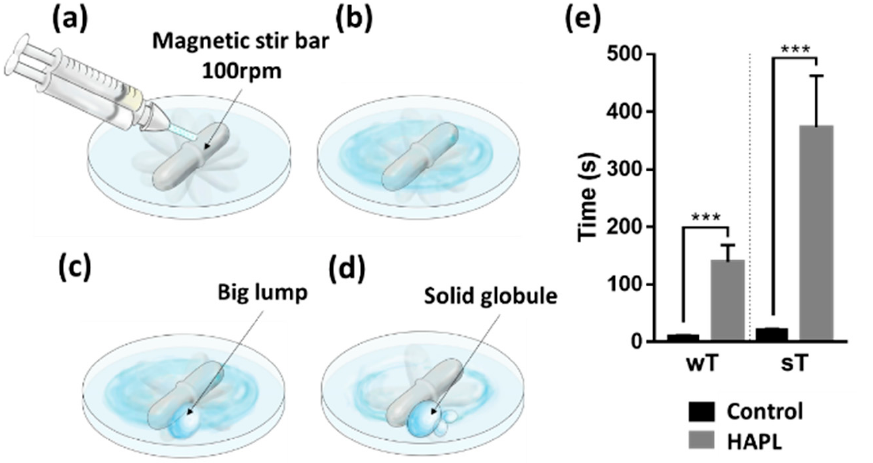
Figure 1. Working and setting time. ( a ) Injection of the hydrogel precursors directly above the magnetic stir bar. ( b ) As in the previous stage, the mixed solution keeps liquid flowing as the magnetic stir bar rotates. ( c ) Working time (wT) was registered when the first lump outline appeared, and the magnetic stir bar showed a slight impediment to turning. ( d ) Setting time (sT) was registered when the hydrogel formed a solid globule that prevented the normal rotation of the magnetic bar. ( e ) Graphic representation of the wT and sT obtained for the control and HAPL hydrogels. Values represent the mean ± SD of 5 tests. Symbols (***) denote study groups with statistically significant difference p <